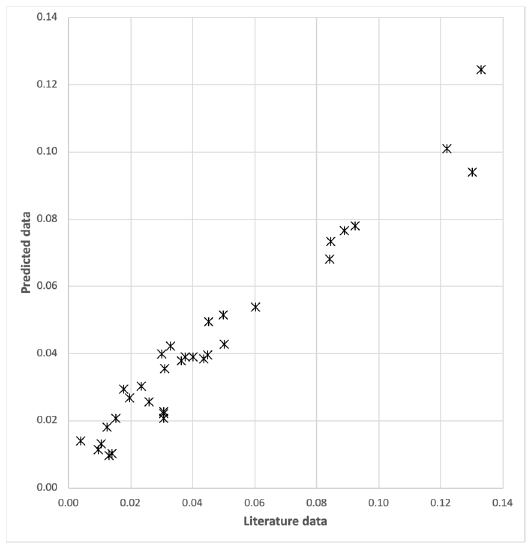
Figure 3. Predicted data versus literature data.